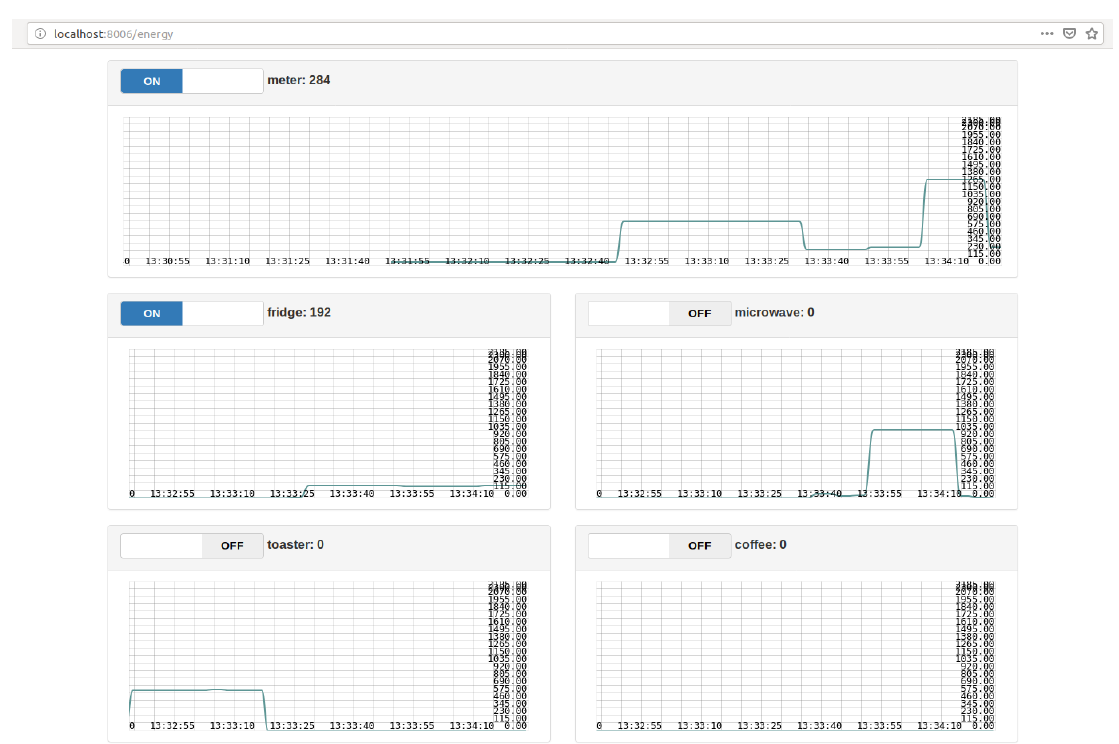
Figure 13. Energy data visualization.